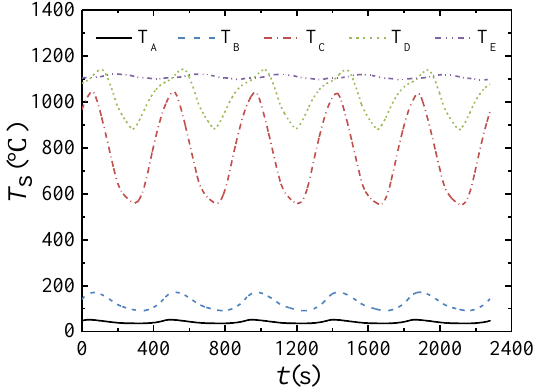
Figure 5. Solid temperature ( T s ) fluctuation at the monitoring points in bed 1 during five cycles when F in = 105 × 10 3 Nm 3 /h, Y CH4,in = 0.94 vol %, and t c = 450 s.